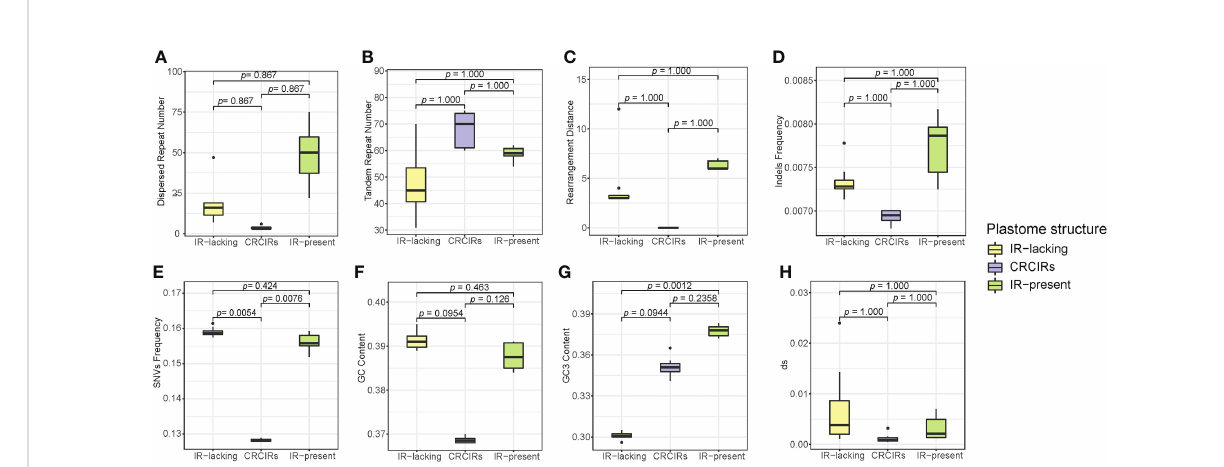
FIGURE 4 Boxplots for phylogenetic ANOVA statistical with post-hoc tests of eight variables between IR-lacking plastomes IR-present plastomes with variation and their CRCIRs. (A) dispersed repeat number; (B) tandem repeat number; (C) rearrangement distance; (D) indels frequency; (E) SNVs frequency; (F) whole plastome GC content; (G) GC3 content; (H) synonymous substitution